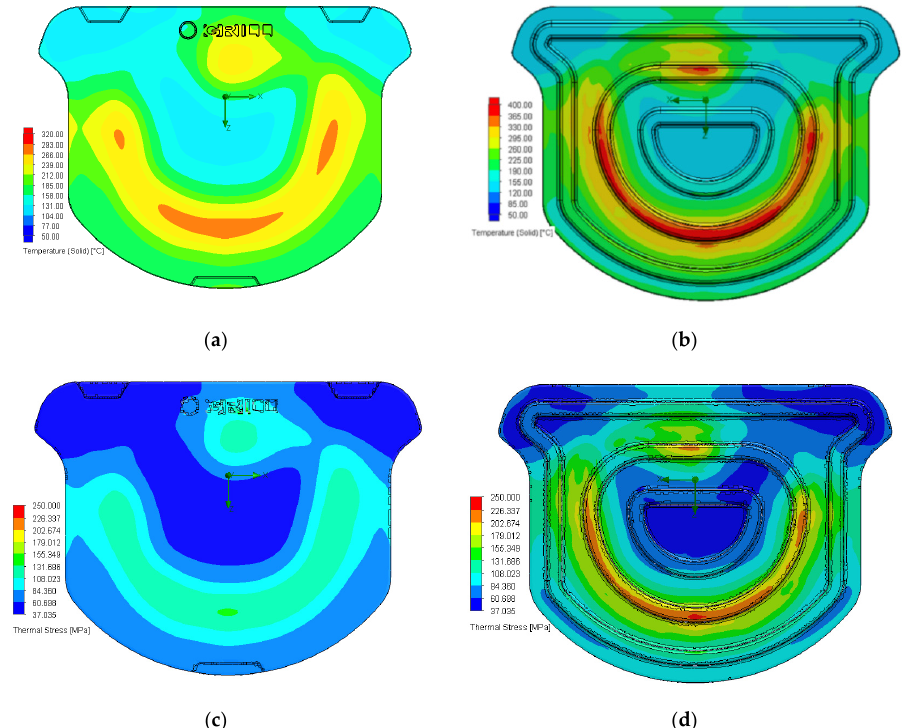
Figure 11. CA#1 stone grill plate. Temperature distribution on the ( a ) top surface and ( b ) bottom of the plate. Thermal stress distribution on the ( c ) upper surface and ( d ) bottom of the plate. The flame contact of improved design #1, which is a continuous rib design, is shown in Figure 12a. This design still suffers from uneven thickness and localized stress. There- fore, improved designs #2 and #3 are introduced (Figure 12b,c, respectively) to alleviate the local stresses generated by uneven thickness. In improved design #2, the continuous